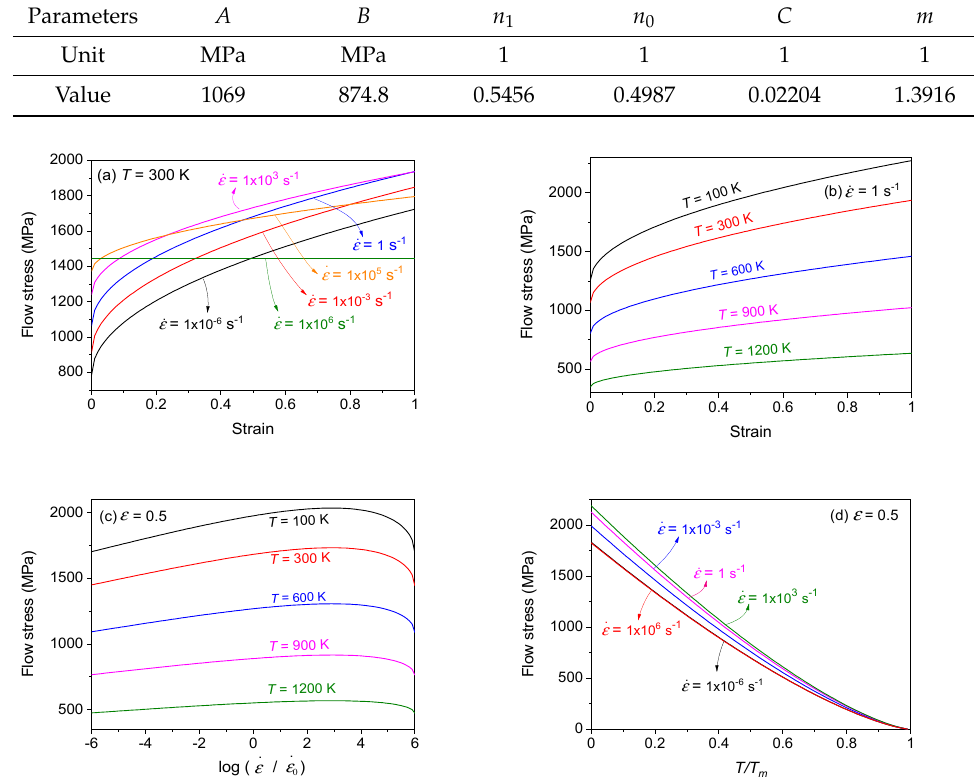
Figure 14. Flow stress–strain curves of Ti–6Al–4V predicted using the KHL model ( a ) at 300 K for different strain rates and ( b ) at 𝜀(cid:4662) = 1 for different temperatures. Change in flow stress at 𝜀 = 0.5 ( c ) with log ( 𝜀(cid:4662) / 𝜀(cid:4662) (cid:2868) ) for different temperatures and ( d ) with T / T m for different strain rates ( 𝜀(cid:4662) (cid:2868) = 1 s − 1 , 𝜀(cid:4662) (cid:2931)(cid:2912) = 10 6 s − 1 , 𝑇 0 = 296 K, and T m = 1933 K).